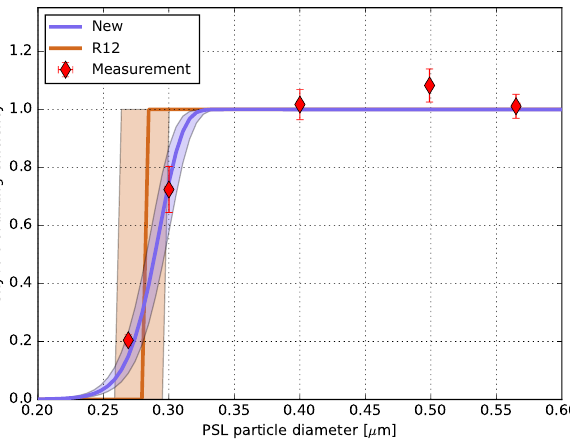
Figure 8. Comparison between modeled and measured SkyOPC (bins 1–15) counting efficiency. The measured mean counting effi- ciency values are plotted with red diamond markers and their asso- ciated 68% confidence intervals with red error bars. The solid lines represent the model best estimates for the different approaches. The shaded areas correspond to the range between the 16 and 84th per-